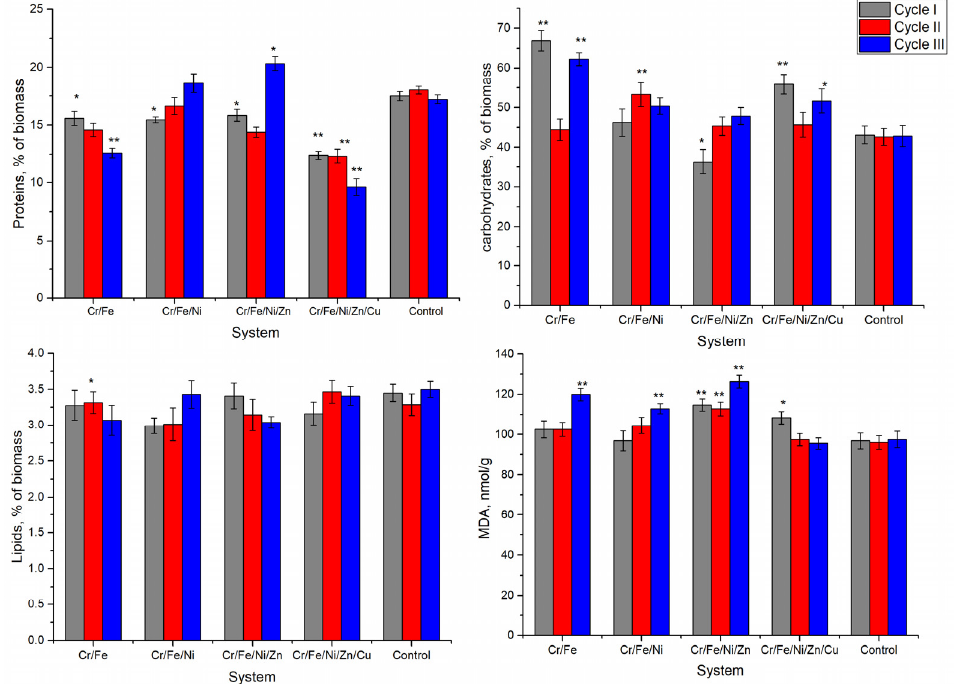
Figure 3. Biochemical composition (total proteins, carbohydrates, lipids, and malondialdehyde) of Nostoc linckia biomass during three cycles of cultivation containing multi-metallic systems. (* p < 0.005; ** p < 0.001) .